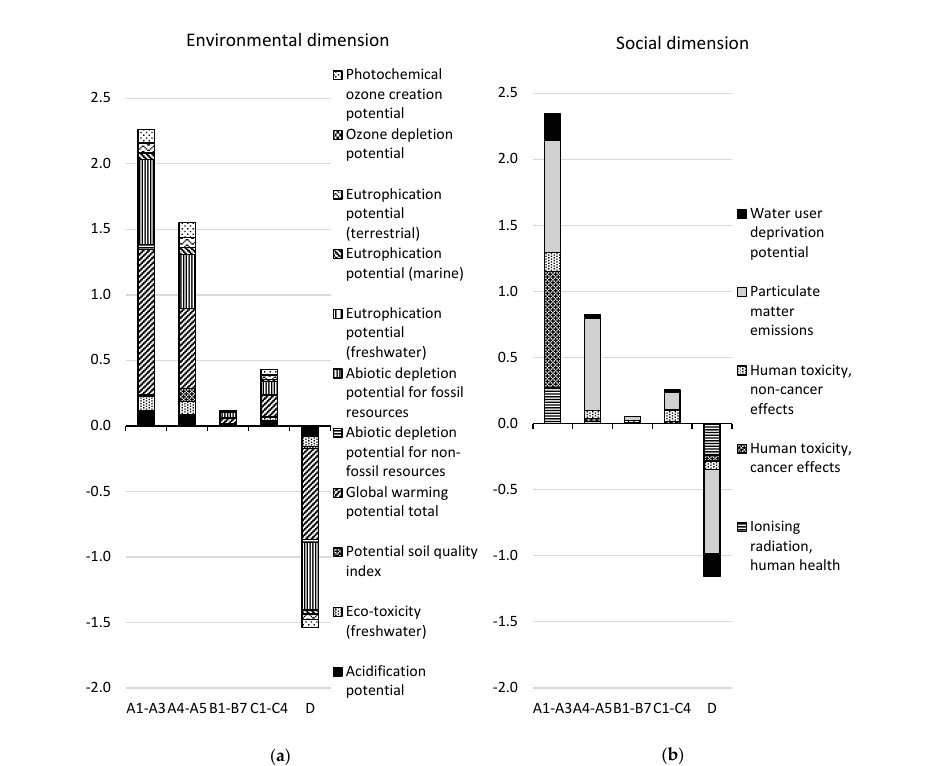
Figure 2. Normalized and weighted results for the CSF bridge design concept per life cycle stage in ( a ) the environmental dimension and ( b ) the social dimension for each indicator and for the functional unit. Module B8 is not included. See Figure 4 for module B8. Note that the ozone depletion potential indicator bar cannot be seen in the figure since it is very